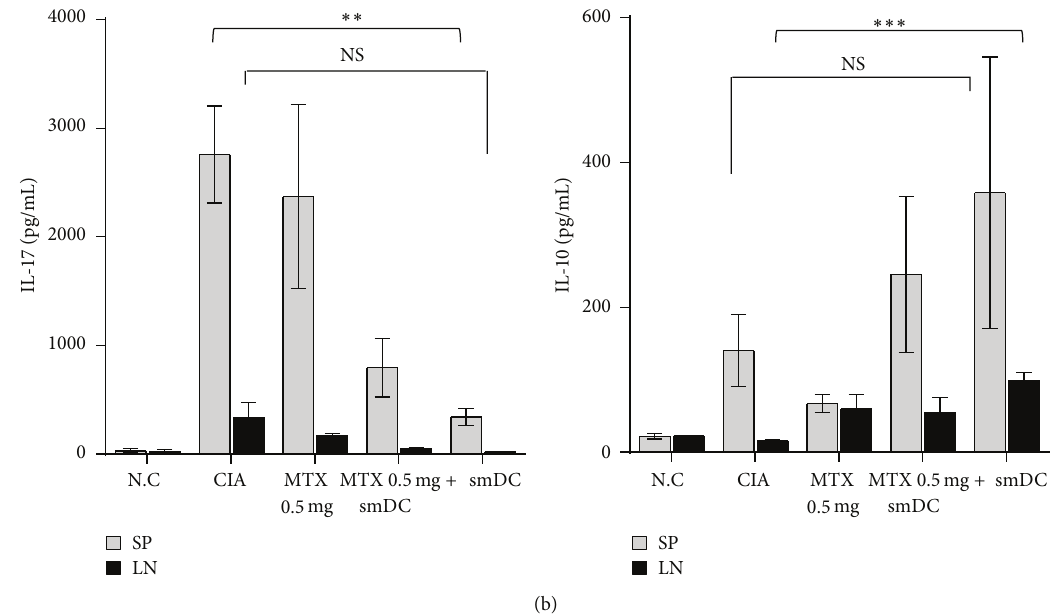
Figure 4: Combination therapy with smDCs and MTX enhanced Treg population and inhibited Th1/Th17 immunity with little influence on Th2 immunity. Advanced CIA mice were treated with smDCs, MTX, or smDCs and MTX, and T cell subsets were analyzed on day 77 after first CII injection. (a) Splenocytes and lymph nodes cells were cultured in the presence of CII (50 𝜇 g/mL) for 72 h. Treg population and Foxp3 mRNA expression were analyzed by flow cytometry and qRT-PCR, respectively. (b) Single cell suspensions were cultured with 50 𝜇 g/mL CII for 72 h. Cytokines secreted from the culture of splenocytes and lymph node cells were assessed. The levels of IFN- 𝛾 , IL-17, and IL-10 were measured by ELISA in the culture supernatants. Statistical data are shown from more than 3 different sets of experiments as mean ± SEM. ∗ 𝑝 < 0.05 , ∗∗ 𝑝 < 0.001 , ∗∗∗ 𝑝 < 0.0001 in Student’s 𝑡